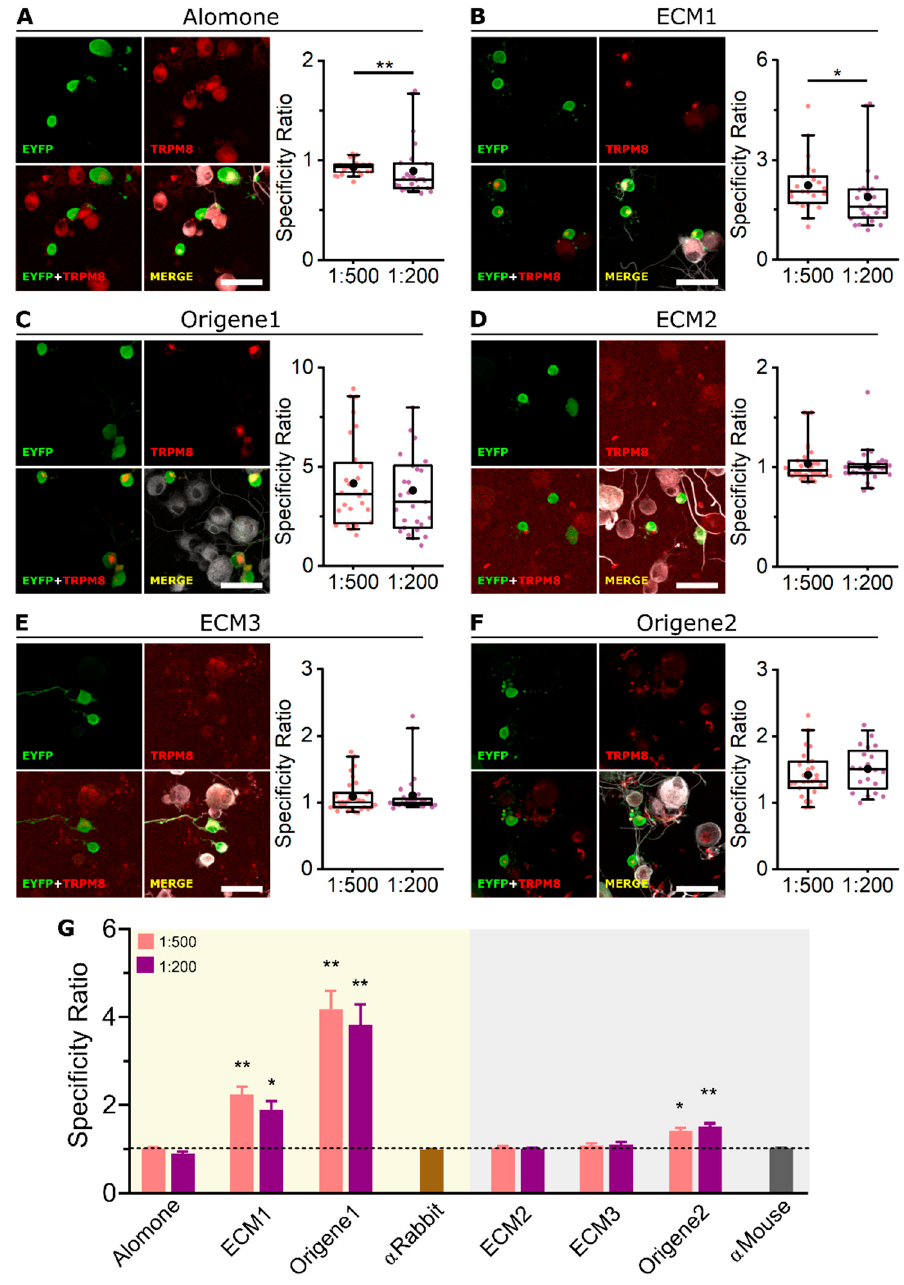
Figure 5. Immunocytochemistry of endogenous TRPM8 in cultured DRG cells from the Trpm8 BAC - EYFP + mouse. ( A – F left) Confocal images of TRPM8+ sensory neurons. EYFP (green), TRPM8 antibody (red) and β III-Tubulin (grey). Scale bar: 50 µm. ( A – F right) Box plots represent specificity ratio (SR) for each dilution of the respective antibody. Each dot corresponds to an individual EYFP+ cell. Box contains the 25th to 75th percentiles. Whiskers mark the 5th and 95th percentiles. The line inside the box denotes the median and the black dot represents the mean (* p < 0.05, ** p < 0.01, Mann–Whitney test). ( G ) Bar histogram summarizing the SR mean ± SEM of each TRPM8 antibody and the controls without primary antibody ( α Rabbit or α Mouse secondary antibodies alone). Dashed line indicates SR = 1 (* p < 0.05, ** p < 0.01, Kruskal–Wallis followed by Dunn’s post hoc test vs. α Rabbit or α Mouse). n = at least 20 cells; 4 pictures from 2 mice for each antibody and dilution.